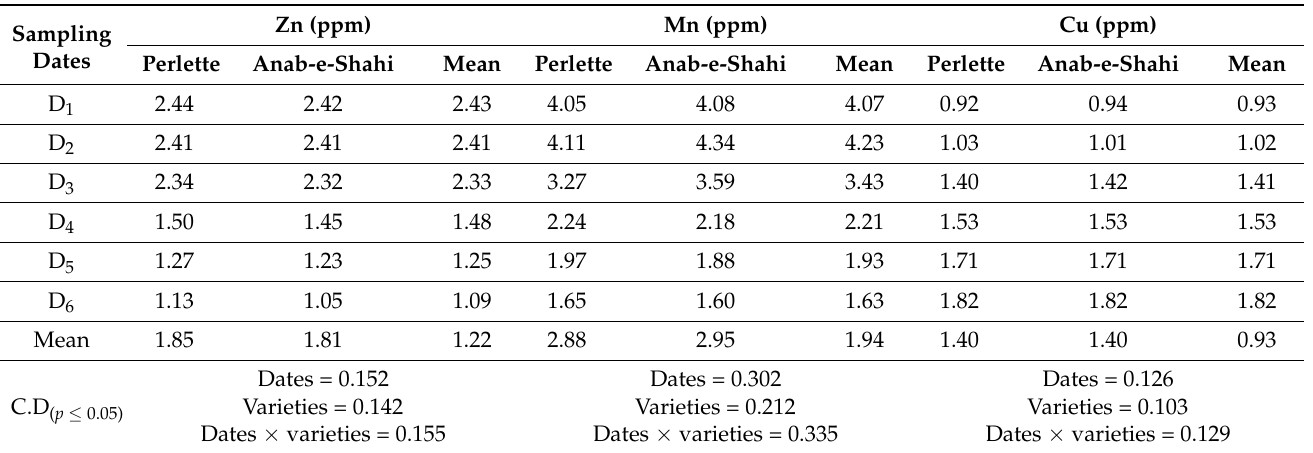
Table 3. Periodic variation of micronutrients (Zn, Mn, and Cu) in developing berries of grapes during the growing season.